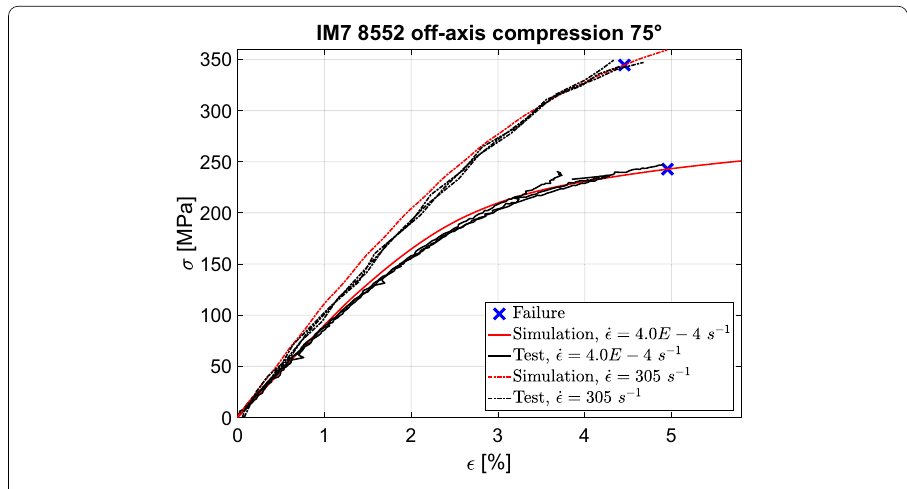
Fig. 20 True stress–true strain curves for the compression tests and simulations, 75 ◦